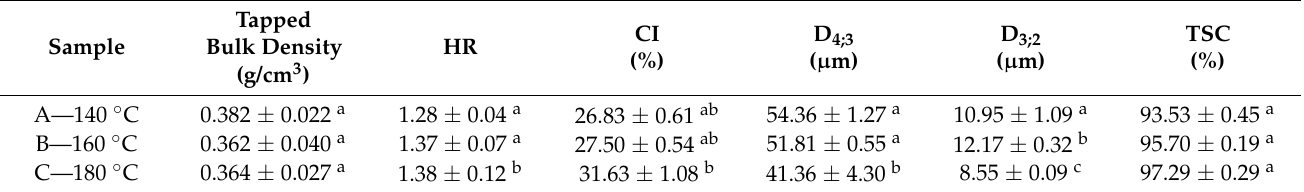
Table 1. The effect of spray-drying conditions on tapped bulk density, flowability, cohesiveness, particle size and Total Solids Content (TSC) of experimental